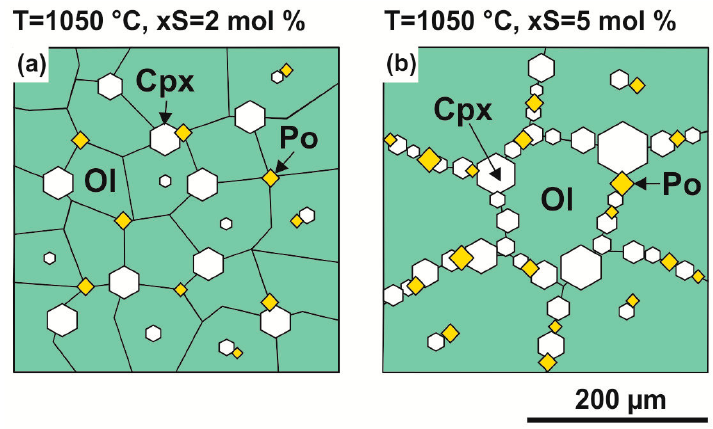
Figure 2. Schematic images of experimental products in olivine–anhydrite–C system, at 1050 °C, xS = 2 mol % ( a ) and xS = 5 mol % ( b ); Ol —olivine, Cpx —clinopyroxene, Po —pyrrhotite.